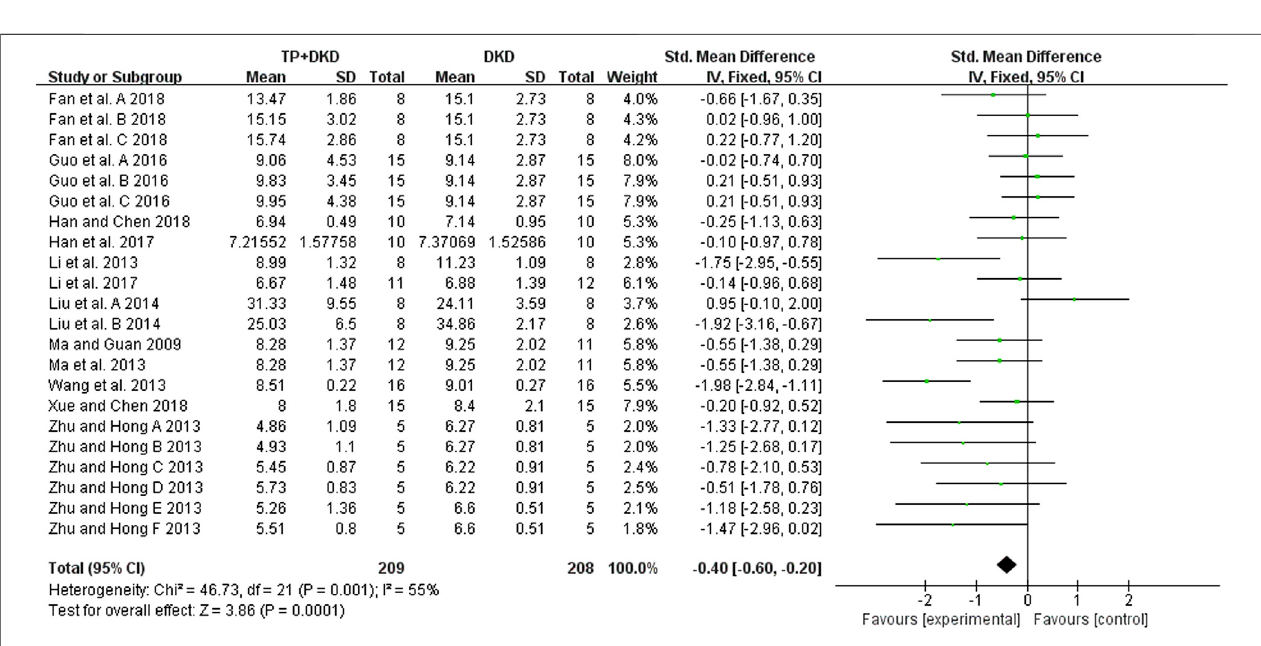
FIGURE 8 | Forest plot of BUN outcome.